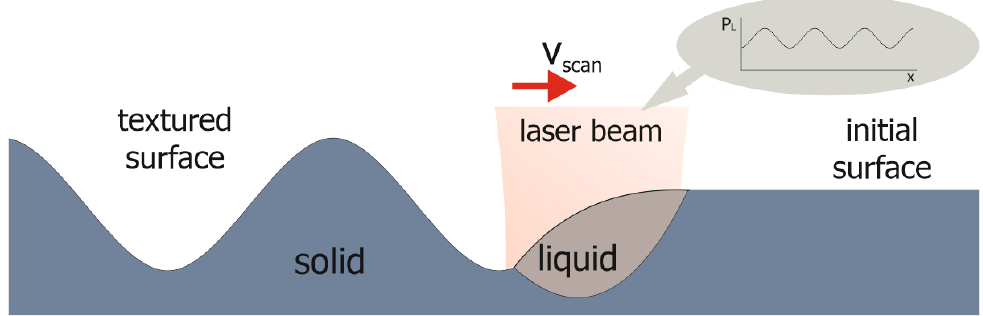
Figure 1. Scheme of Waveshape